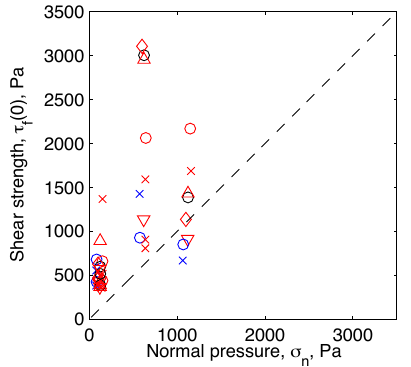
Figure 5. Influence of σ n on τ f ( 0 ) (dashed line – 1 : 1; marker code is the same as in Fig.